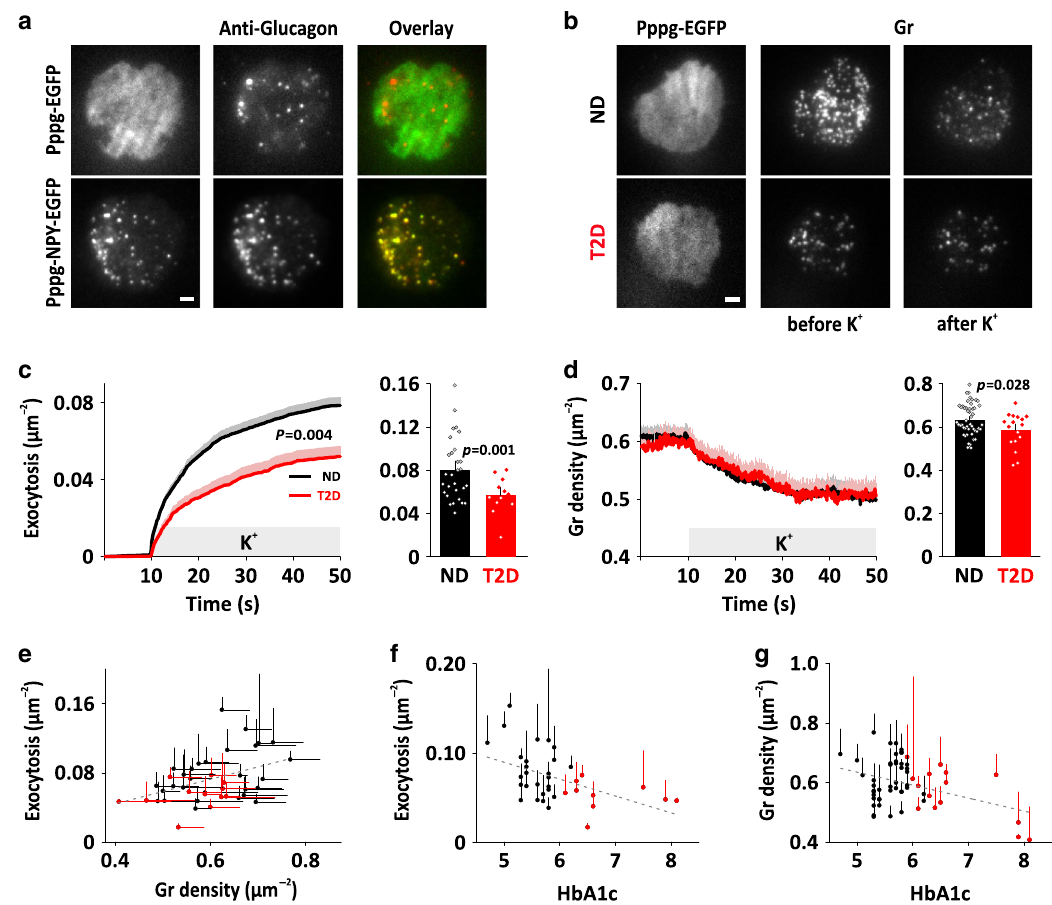
Fig. 1 Exocytosis of glucagon granules in normal and diabetic pancreatic α -cells. a TIRF images of dispersed human islet cells transduced with Pppg- EGFP (top) or Pppg-NPY-EGFP (bottom). In total, 90% of EGFP expressing cells ( n = 91 cells, 5 donors) and 93% of NPY-EGFP expressing cells ( n = 70 cells, 4 donors) were positive for glucagon. Scale bar 2 µ m. b Examples of TIRF microscopy of cells from non-diabetic (ND) and type 2 diabetic (T2D) donors expressing Pppg-EGFP together with the granule marker NPY-mCherry (gr). Examples are before and after stimulation with 75 mM K + for 40 s. (K + was elevated during 10 – 50 s). Scale bar 2 µ m. c Timecourse of average cumulative number of exocytotic events normalized to cell area in experiments as in b (left); 1530 granules in 169 ND cells (black), 441 granules in 75 T2D cells (red). Exocytosis (right) was 0.055 ± 0.005 gr µ m − 2 in 12 T2D donors compared with 0.077 ± 0.005 gr µ m − 2 in 29 ND donors ( p = 0.001, two-tailed t -test). In c , d , timecourse (left) shows mean ± SEM of all cells, bargraphs (right) show donor means (dots) and mean ± SEM of individual donor means (bars). d Time courses of granule (gr) density (left) in ND or T2D cells as in b . Glucagon density (right) was 0.56 ± 0.017 gr µ m − 2 in 17 T2D donors compared with 0.61±0.01 gr µ m − 2 in 50 ND donors ( p = 0.028, two-tailed t -test). e Total exocytosis during K + -stimulation plotted as function of granule density. Each symbol in e – g represents represent individual donors ± SEM (averages for n = 29 ND donors in black, and n = 12 T2D donors in red; 5 – 20 cells for each donor). Correlation was quanti fi ed as Pearson coef fi cient r (see main text). f Total exocytosis during K + -stimulation plotted as function of donor HbA1c. n = 26 ND donors and n = 10 T2D donors. g Granule density as function of donor HbA1c; n = 40 ND and n = 15 T2D